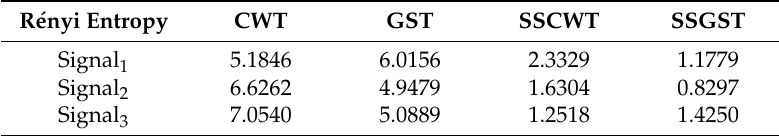
Table 1. The R é nyi Entropies of three synthetic examples based on the Continuous Wavelet Transform (CWT), Generalized S-transform (GST), Synchrosqueezing continuous wavelet transform (SSCWT), and Synchrosqueezing Generalized S-transform (SSGST) methods. Signal 1 is the double hyperbolic chirped signal. Signal 2 is the double hyperbolic chirped signal. Signal 3 is the synthesized signal.